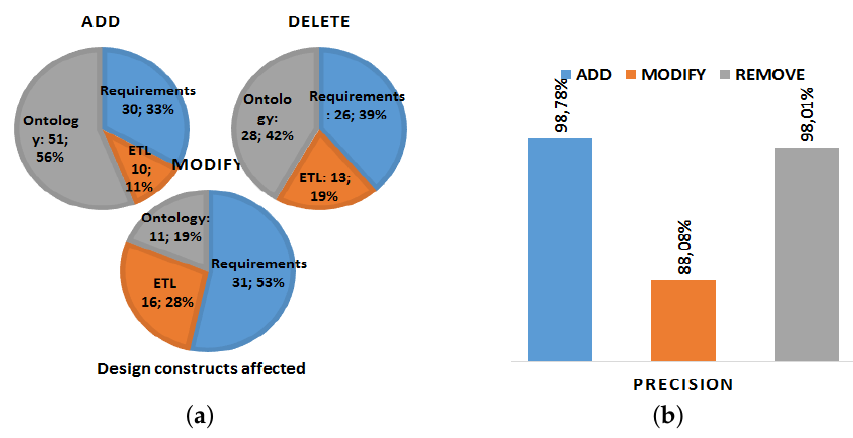
Figure 9. ( a ) Design constructs affected by the changes and ( b ) Precision of the evolution